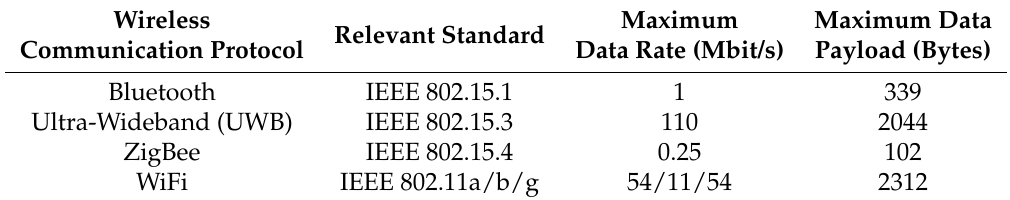
Table 2. Relevant protocols for industrial sensing intelligence (ISI)-based factory